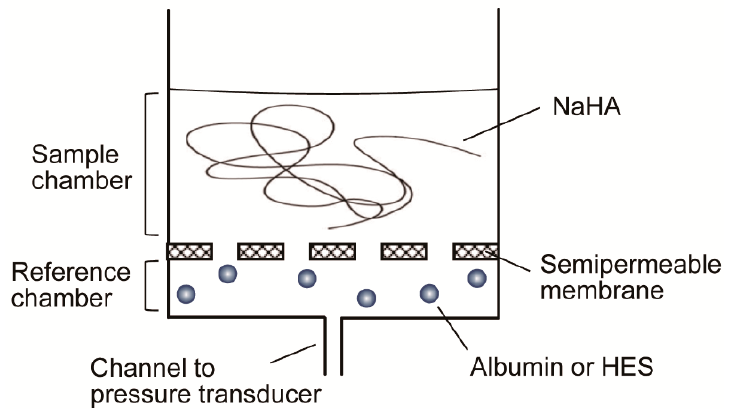
Figure 2. Schematic of an osmotic flow cell. Fluid flows from the reference chamber to the sample chamber due to osmotic swelling of sodium hyaluronic acid (NaHA) in phosphate buffered saline (PBS). The sample chamber was filled with 0.5 mL 1% NaHA solution, and the reference chamber was filled with PBS, 2% albumin, or 2% hydroxyethyl starch solution (HES). A semipermeable membrane with a molecular weight cut-off of 300,000 was used.